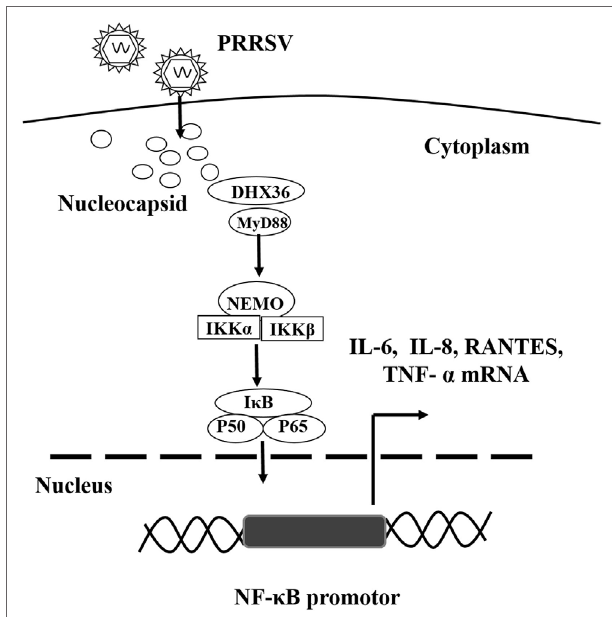
FigUre 8 | Proposed model illustrating the DExD/H-box helicase 36 (DHX36)–MyD88 axis involvement in PRRSV N protein-induced NF- κ B signaling. PRRSV infection induces the up-regulation and relocalization of DHX36 from the nucleolus to the cytoplasm. DHX36 in the cytoplasm senses the N protein of PRRSV and then recruits MyD88 to facilitate P65 phosphorylation, which in turn initiates NF- κ B-dependent IL-6, IL-8, TNF- α and RANTES